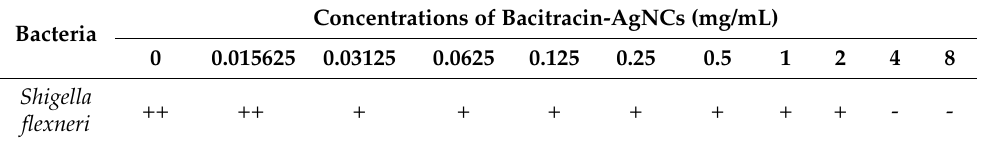
Table 2. Minimum inhibitory concentration (MIC) and minimum bactericidal concentration (MBC) of Bacitracin-AgNCs against S. flexneri